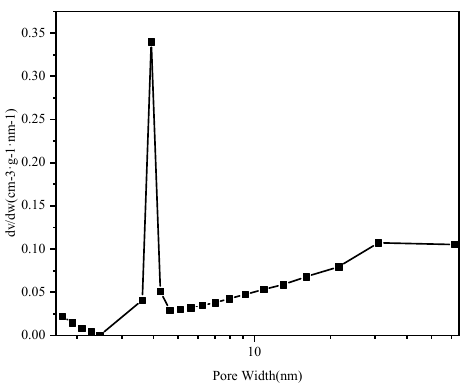
Figure 6. Aperture distribution curve of MGO@ZIF-8.